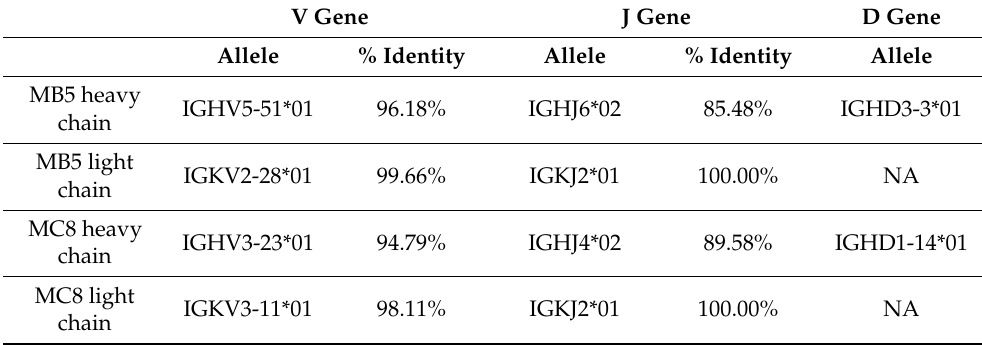
Figure 4. Deduced amino acid sequences of variable domains of the MB5 and MC8 clones. The sequences of the variable regions of heavy and light chains (VH and VL) of MB5 and MC8 clones are shown. CDR1-3 regions are indicated in red. Table 2. Deduced germline genes and level of mutation of the 2 anti-SARS-CoV-2 mAbs.